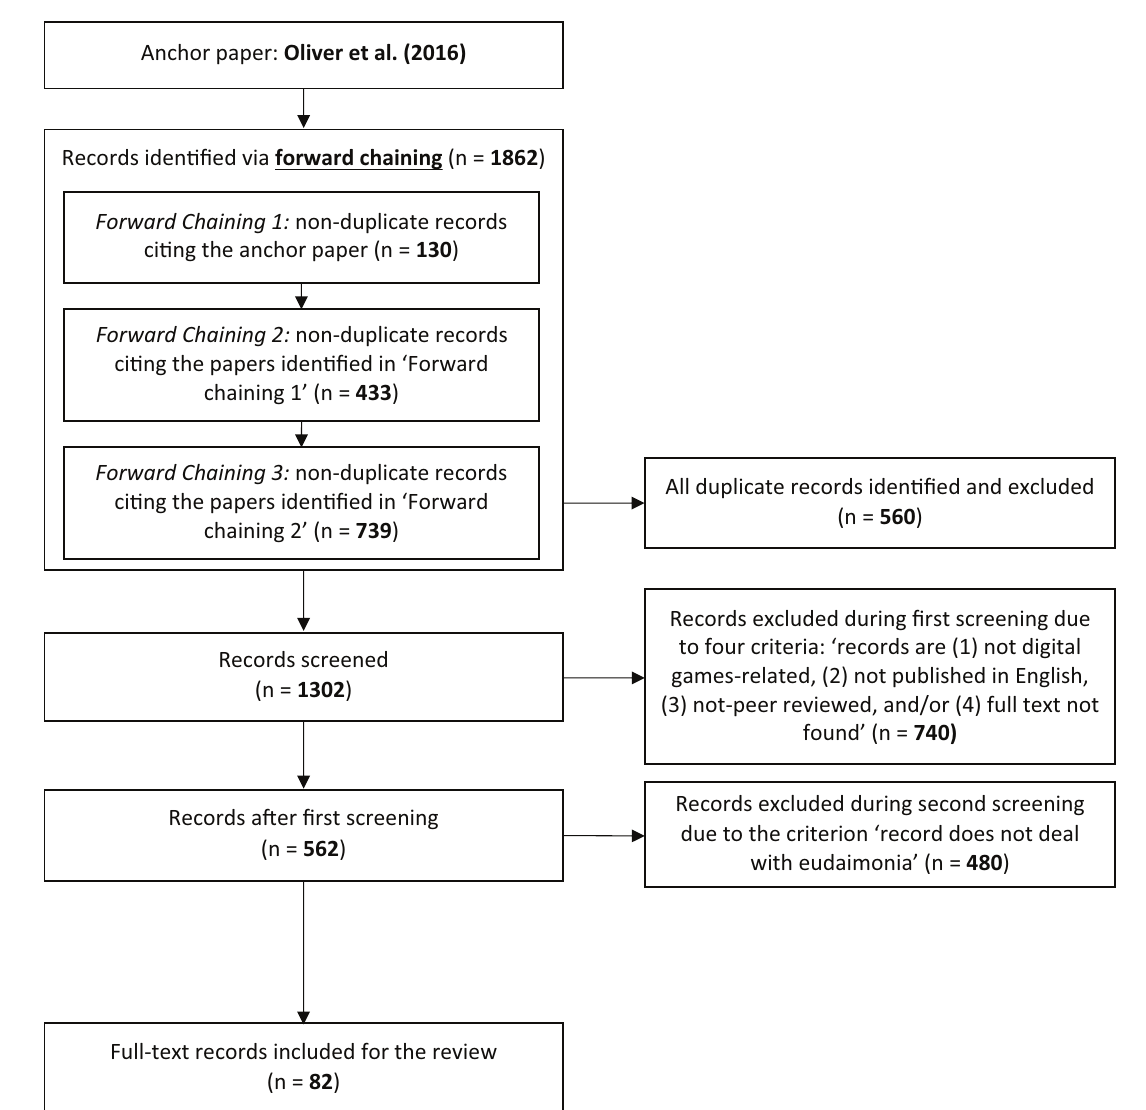
Figure 1. Flow diagram of the record search and inclusion/exclusion